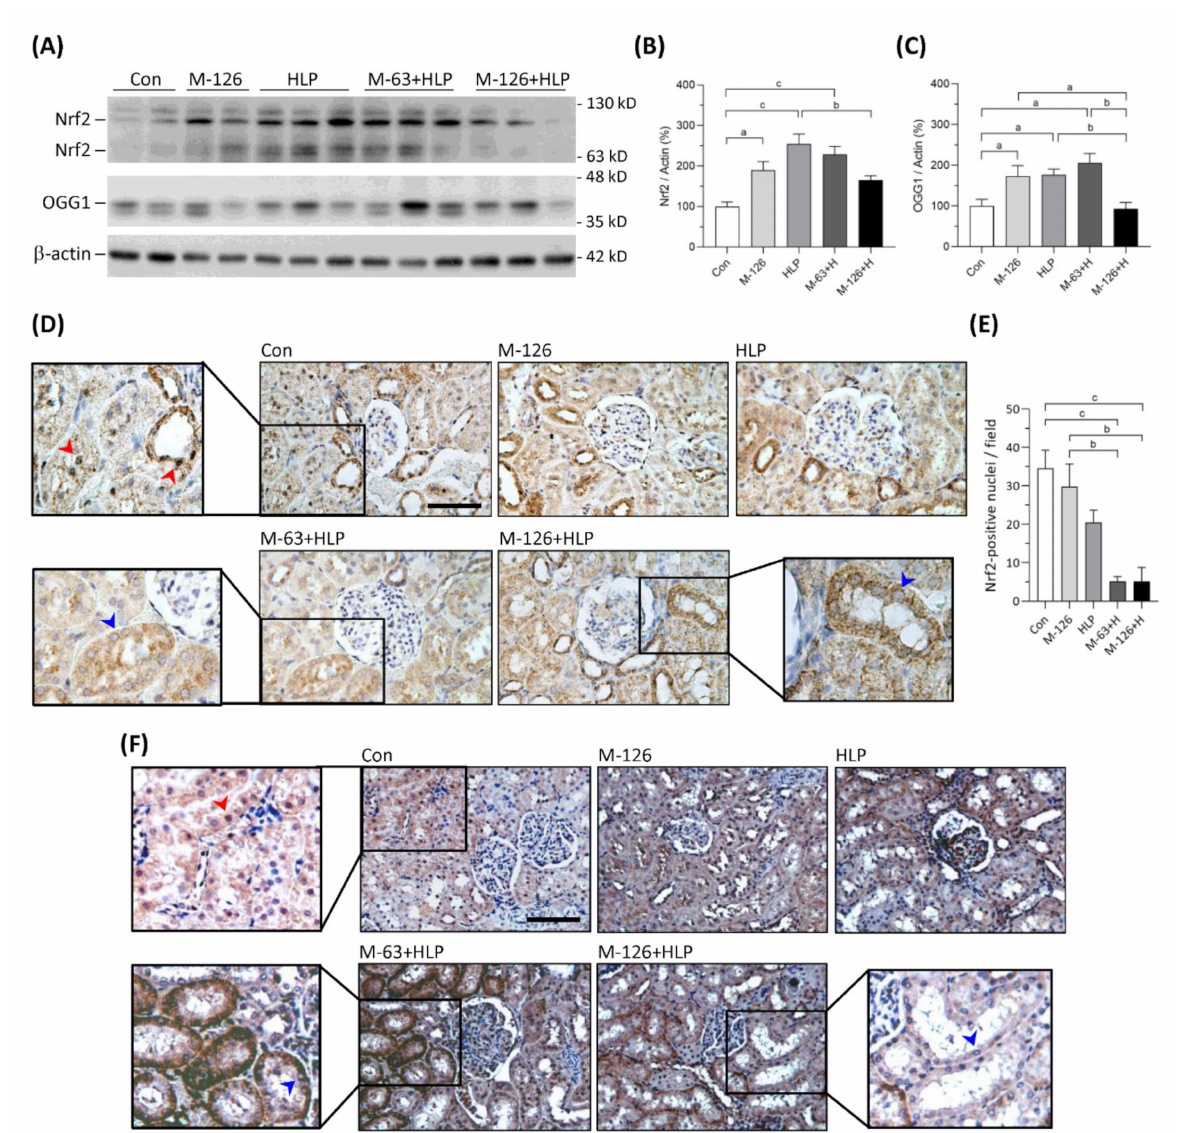
Figure 9. Protein expression of Nrf2 and OGG1 in kidneys of the SD rats. ( A ) Representative images of the immunoblots. The protein levels of Nrf2, OGG1 and β -actin were detected by western blotting. ( B , C ) Quantified results for the western blotting ( n = 9–10 for each group). ( D ) Representative images of Nrf2 IHC staining. ( E ) Quantified results of Nrf2 presented in the cell nuclei of renal tubules ( n = 6 for each group). ( F ) Representative images of OGG1 IHC staining. Brown color indicates positive stains of Nrf2 or OGG1 proteins detected with DAB substrate. Red arrowheads indicate that Nrf2 or OGG1 are present in cell nuclei of the renal tubules. Blue arrowheads indicate that Nrf2 or OGG1 are not able to translocate in cell nuclei of the damaged renal tubules. Con: control; HLP: 2% hydroxy-L-proline; Mel-126: melamine 126 mg/kg/day; Mel-63: melamine 63 mg/kg/day. Data are mean ± SE. a: p < 0.05; b: p < 0.01; c: p <